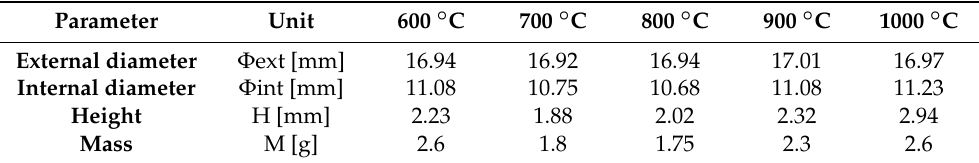
Table 1. Basic parameters of specimens at different sintering temperatures.